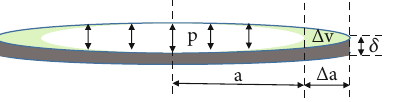
Figure 9: Propagation of